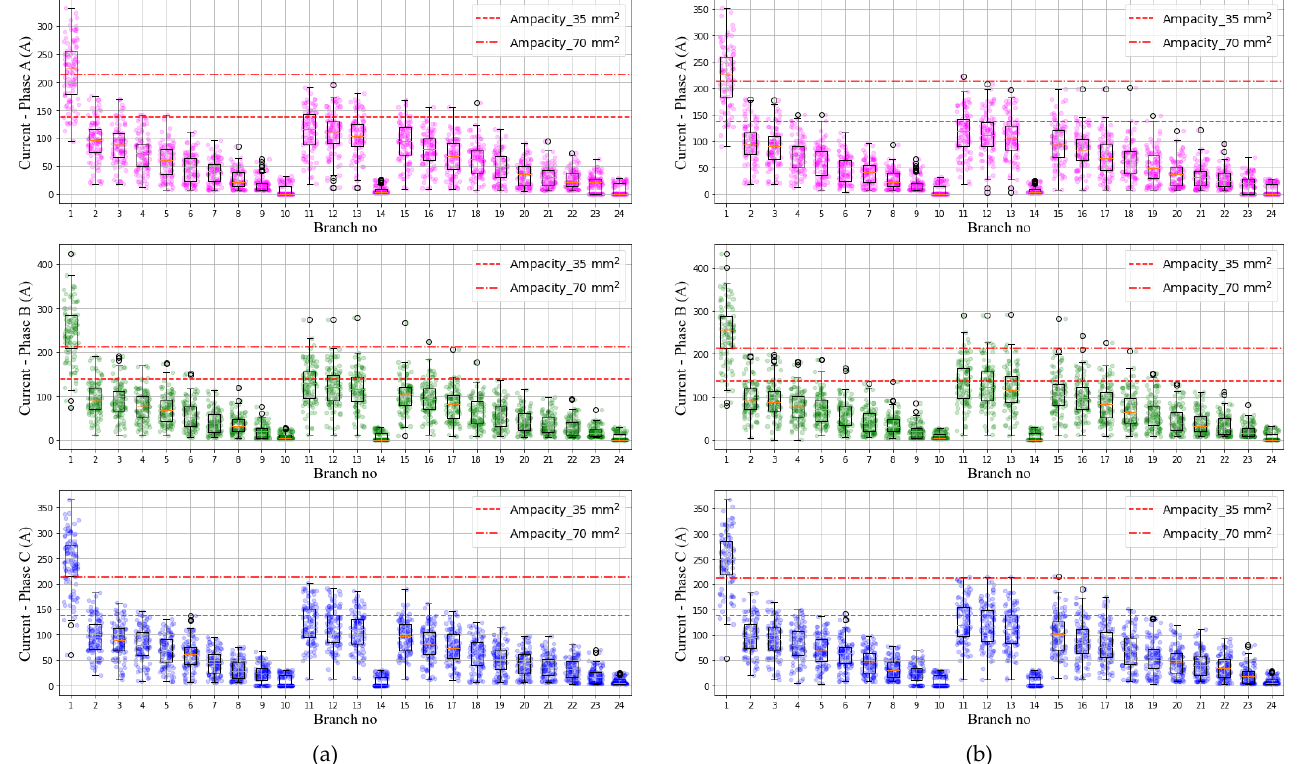
Figure 5. Variation of branch currents of the LVDN for ( a ) without VC and ( b ) with VC conditions for 100 Monte Carlo simulations — 200 kW.